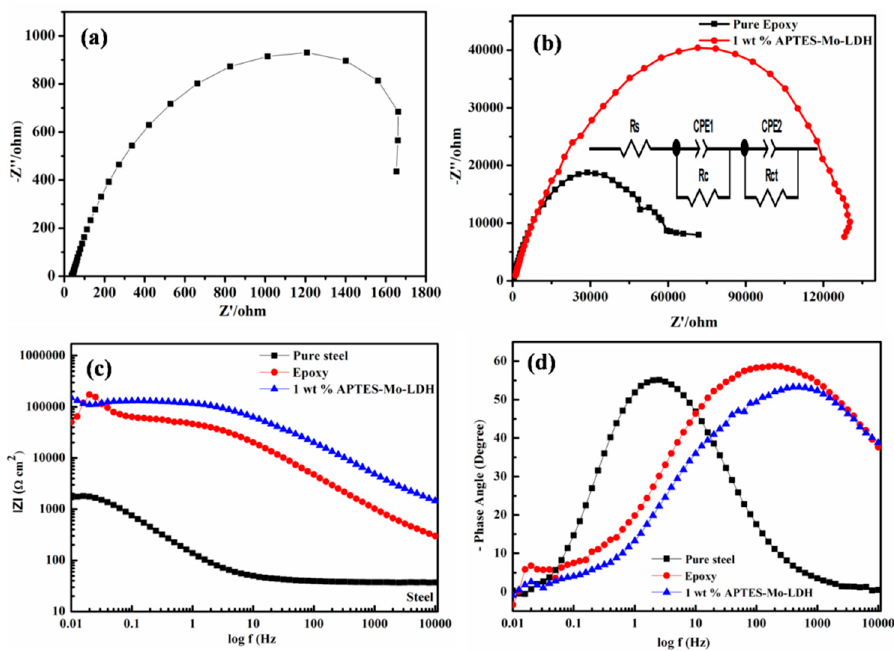
Figure 6. ( a , b ) Electrochemical impedance spectroscopy (EIS) plots of bare steel, epoxy coating, and composite coating. ( c , d ) Bode plots of bare steel, epoxy coating, and composite